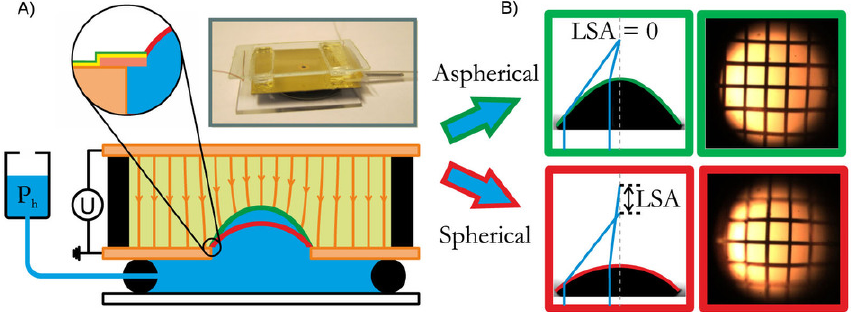
Figure 8. ( A ) Schematic of the aspherical lens device with a photograph of the actual device in the inset. Aqueous cesium iodide solution as lens fluid (in blue) with silicone oil as ambient liquid (in yellow). The curvature of the spherical meniscus (in red) at zero voltage is controlled by the hydrostatic head (in black). Application of voltage ‘U’ between the top electrode and the aperture plate (both in orange) distorts the shape of the spherical droplet, thus making a perfect aspherical lens. ( B ) The spherical (red) and aspherical droplet profiles (green) with captured images of the square grid demonstrate the mitigation of longitudinal spherical aberration (LSA). Reprinted by permission from